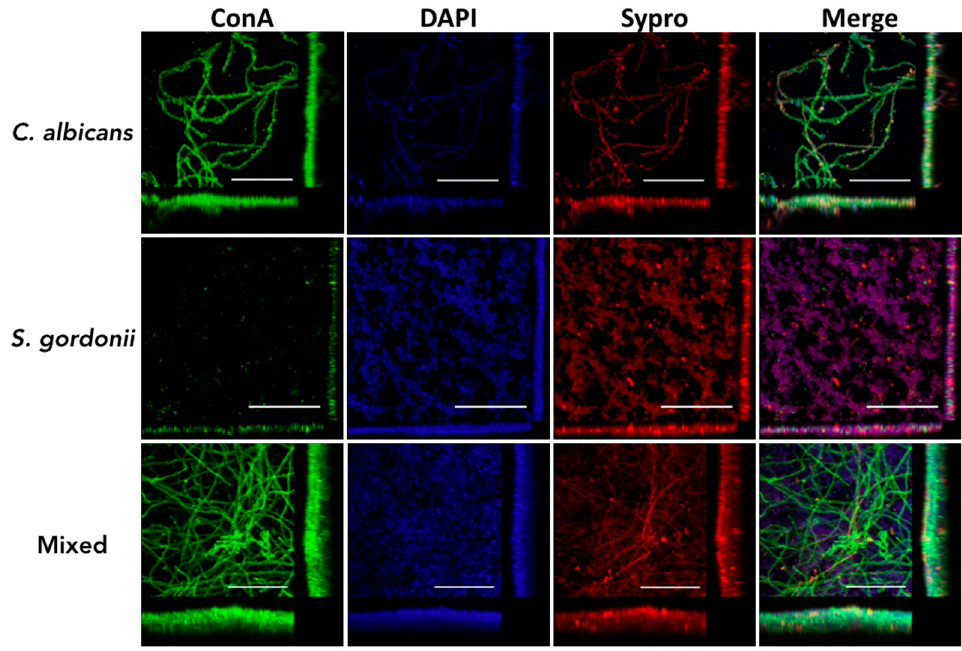
Figure 3. Characterization of C. albicans and S. gordonii single- and dual-species biofilms formed on titanium using confocal laser scanning microscopy (CLSM) and 3D reconstruction software. Biofilms were grown for 24 h in 1:1 v / v RPMI/THB + YE in a 48-well plate containing titanium discs, and stained with Concanavalin A-Alexa Fluor ® 488 conjugate, 1 x FilmTracer™ SYPRO ® Ruby Biofilm Matrix Stain, and DAPI. Scale bar corresponds to 50 µm. Included in the figure are the xy , xz , and yz views of the resulting biofilm. J. Fungi 2018 , 4 , x FOR PEER REVIEW